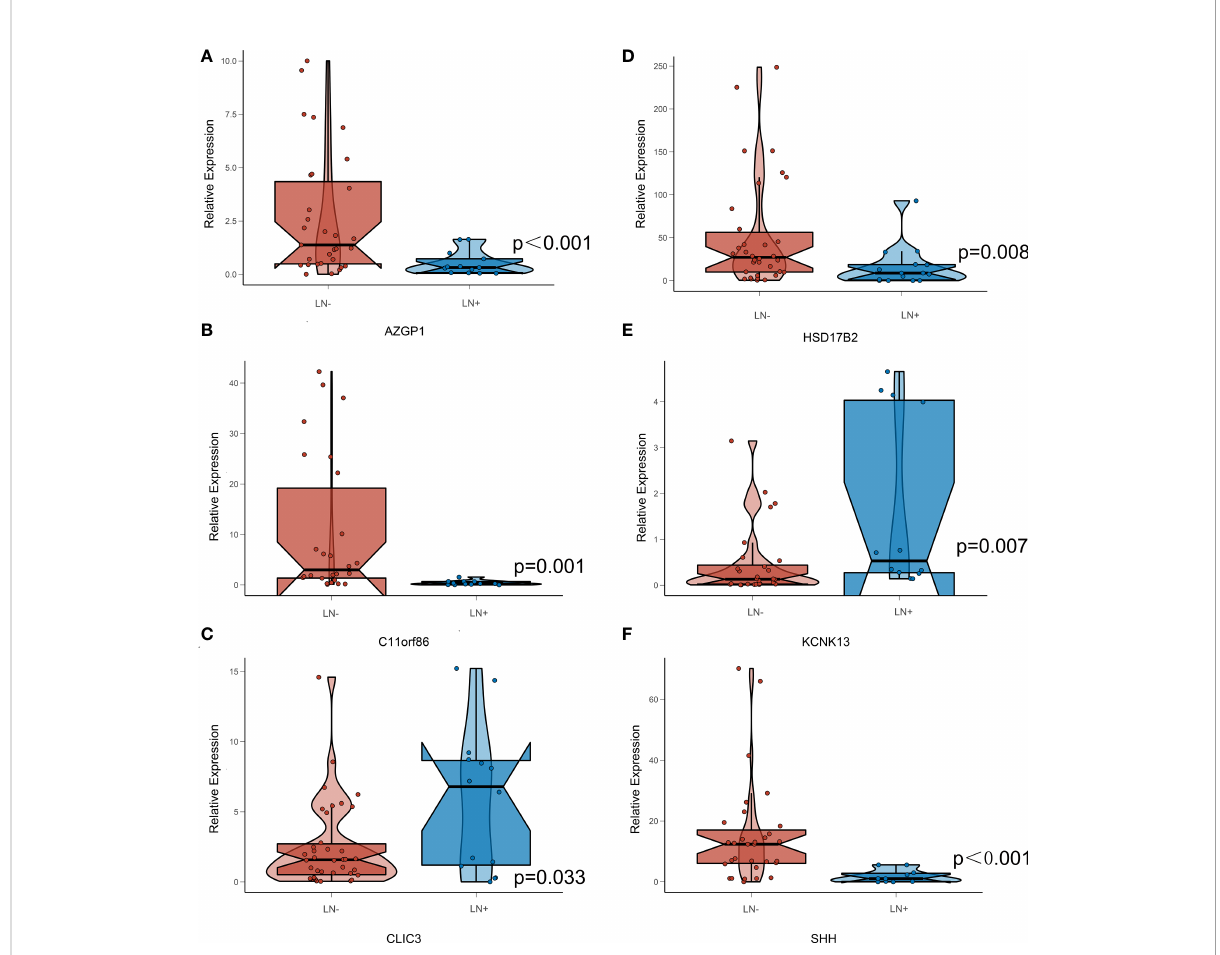
FIGURE 8 Expression Level of StrLNM candidate genes in BLCA patients ’ sample. (A) Expression level of AZGP1 between LN+ and LN- samples. (B) Expression level of C11orf86 between LN+ and LN- samples. (C) Expression level of CLIC3 between LN+ and LN- samples. (D) Expression level of HSD17B2 between LN+ and LN- samples. (E) Expression level of KCNK13 between LN+ and LN- samples. (F) Expression level of SHH between LN+ and LN-